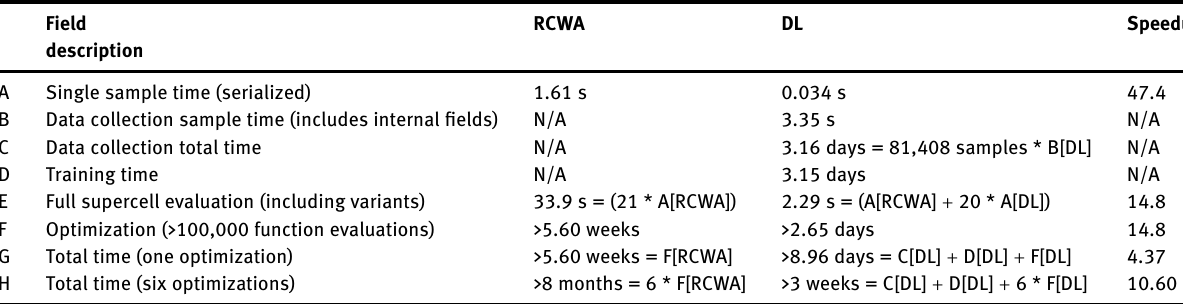
Table  : PerformancecomparisonofrobustnessstudywithandwithoutDLaugmentation.Thecolumnsshowtimingsfordifferentpartsofthe study. The fi eld description column explains what each step is. The RCWA and DL columns each record thetime taken for the different approachesateachstep.Finally,thespeedupcolumnreportstheimprovementintimetakenbyusingtheDLmethodforeachstep.Evenwhen factoringintrainingtime,theDLaugmentedapproachaffordsasubstantialspeedupoverthestandardmethod.Moreover,asshowninrowsG and H, the performance advantage DL affords increases substantially with further optimizations and increases in the number of variations tested for each